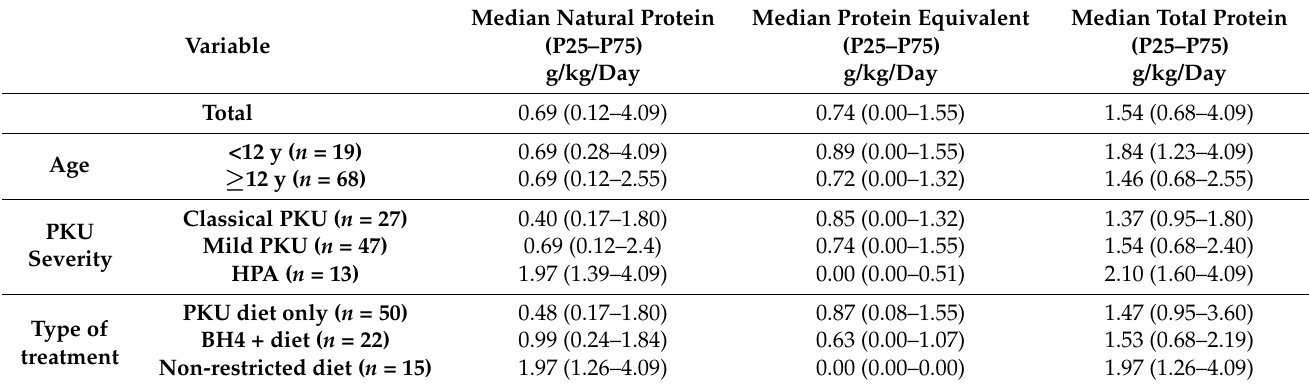
Table 2. Median intake of natural protein, protein equivalent and total